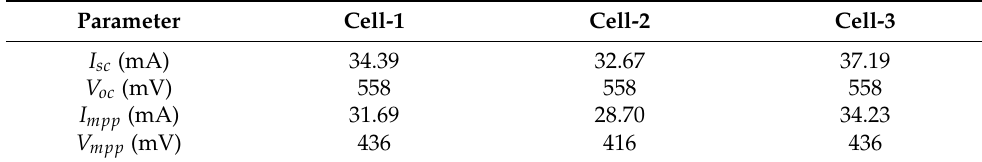
Table 2. Experimental values from IIV of solar cells.